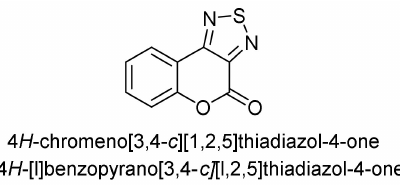
Figure 6. The common isomer of the fused chromeno-thiadiazole system.